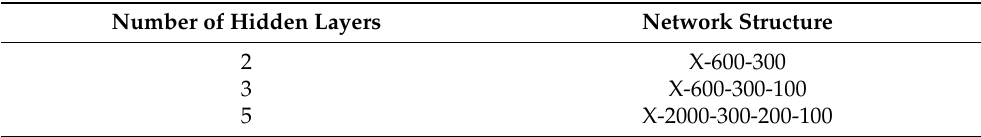
Table 2. Deep belief network structure settings.